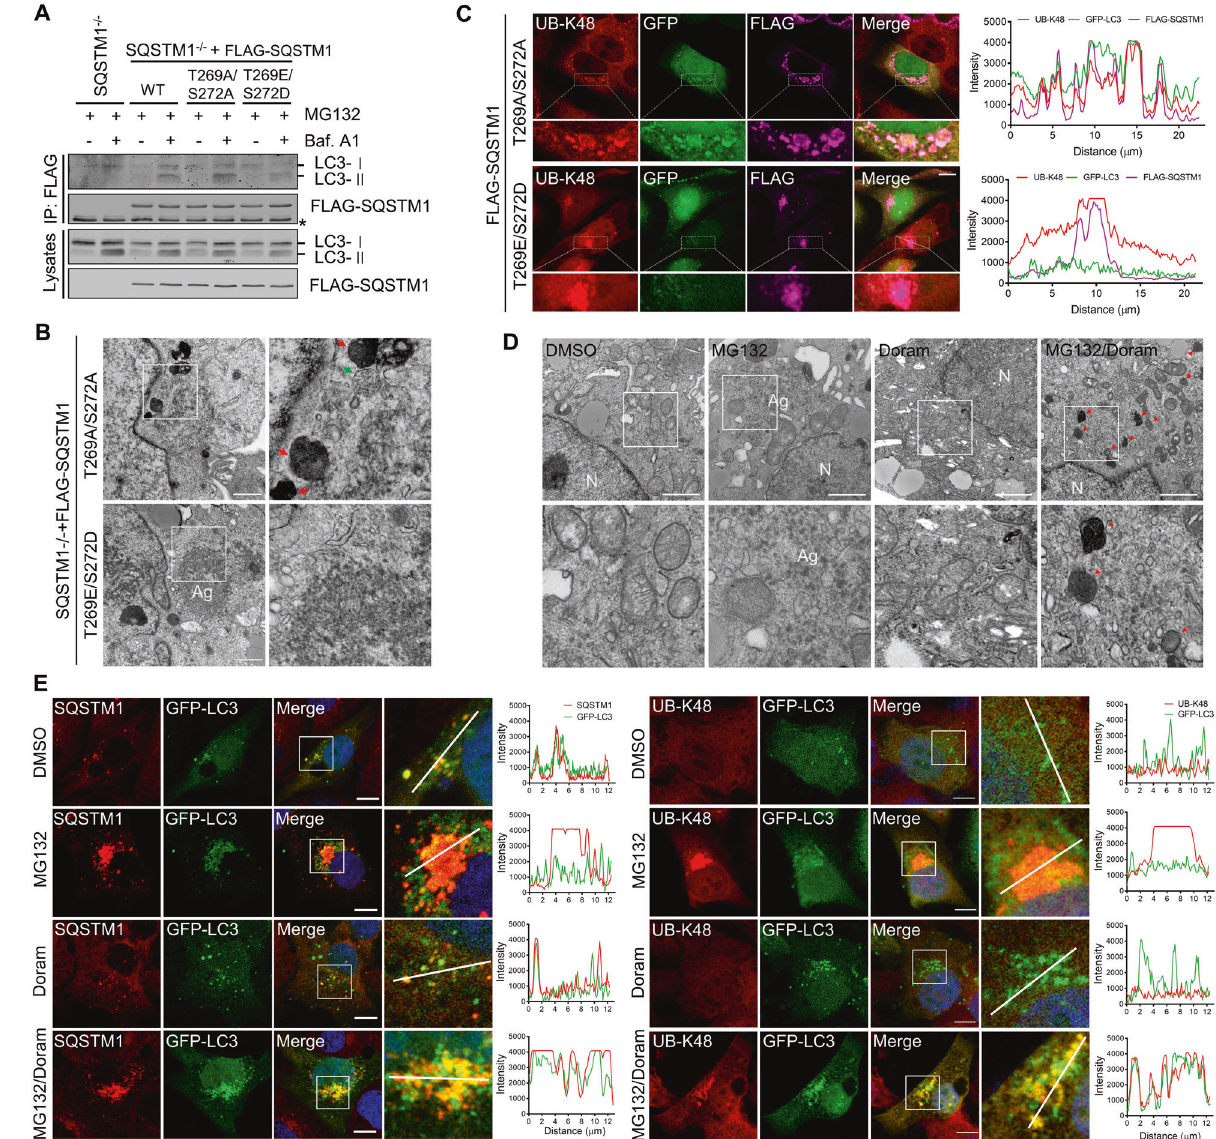
Fig. 6 SQSTM1(T269/S272) phosphorylation inhibits its autophagic receptor activity upon proteasome inhibition. A SQSTM1 − / − and its rescue cell lines were treated with MG132 (10 μ M) with or without Ba fi lomycin A1 (25 nM) for 5 h. Cell lysates were immunoprecipitated with anti-FLAG antibodies. Co-immunoprecipitated proteins were detected by western blot analysis using indicated antibodies. Asterisks indicate IgG. B Representative electron micrographs from SQSTM1 − / − cell lines stably expressing SQSTM1 mutants after treated with MG132 (2 μ M) for 14 h. N, nucleus; Arrows, sequestered aggregates; Ag, aggresome; Scale bar: 1 μ m. C HeLa cells stably expressing EGFP-LC3B were transfected with plasmids expressing FLAG-SQSTM1(T269A/S272A) or FLAG-SQSTM1(T269E/S272D) for 24 h, and then treated with MG132 (1 μ M) and Ba fi lomycin A1 (25 nM) for 14 h. The cells were then fi xed and analyzed by immunostaining with anti-UB-k48 (red) and anti-FLAG (green) antibodies. Nuclei were stained with DAPI (blue). Scale bar: 10 μ m. The fl uorescence intensity line is tracing corresponding to a white line. D Representative electron micrographs from A375 cells after treated with indicated inhibitors (MG132 (2 μ M), Doramapimod (50 μ M)) for 14 h. N, nucleus; Arrows, sequestered aggregates; Ag, aggresome; Scale bar: 1 μ m. E A375 cells were treated with indicated inhibitors (MG132 (2 μ M), Doramapimod (50 μ M)) for 14 h. Cells were then fi xed and immunostained with anti-SQSTM1 or anti-UB-K48 antibodies. Nuclei were stained with DAPI (blue). Scale bar: 10 μ m. The fl uorescence intensity line is tracing corresponding to a white